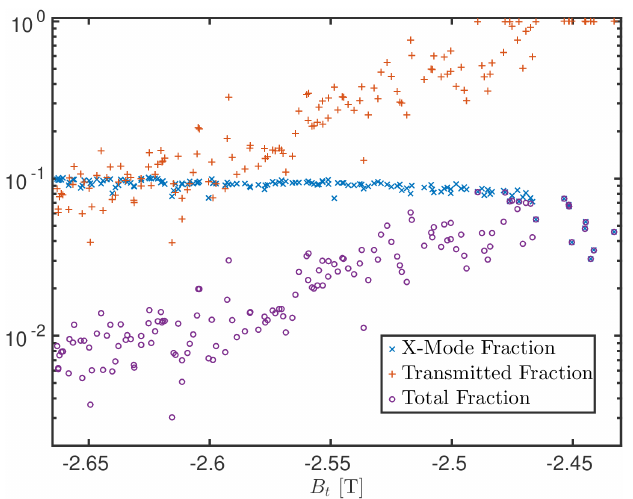
Figure 3. The fraction of reflected power coupled to the plasma in X-mode ( × ), the fraction of power transmitted by the ECR from the gyrotron to the UHR ( + ), and the total fraction of gyrotron power reaching the UHR ( ◦ ), during the B t -scan in ASDEX Upgrade discharge #34575, modelled using the theory of [8]. The X-mode fraction remains relatively constant with values around 0.1 throughout most of the scan. The transmitted fraction increases from approximately 0.1 to 1 during the B t -scan; the relative change in the total fraction is similar to that of the transmitted fraction.